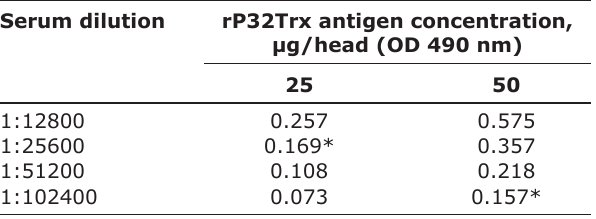
Table-2: Immunogenicity of rP32Trx protein in mice. Serum